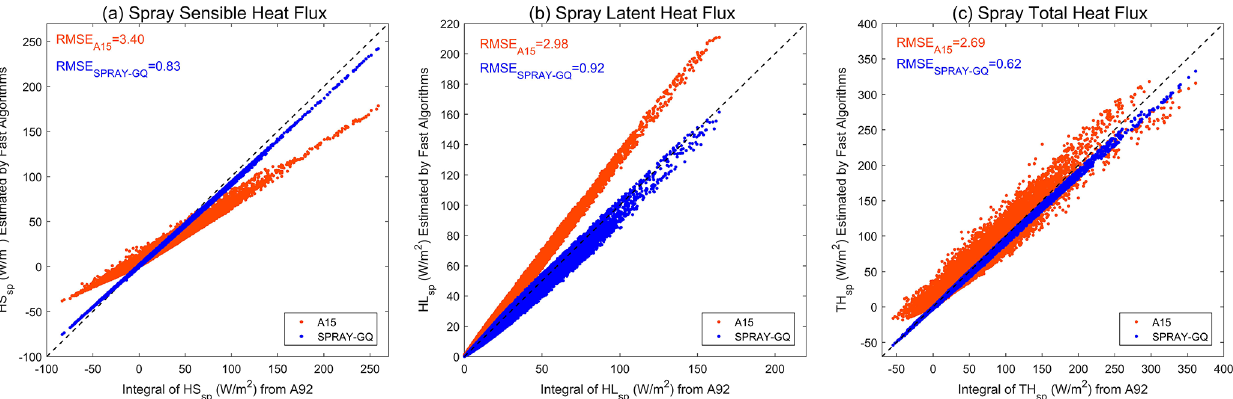
Figure 3. Scatterplots of H S , SP (a) , H L , SP (b) and total heat flux TH SP = H S , SP + H L , SP (c) estimated by fast algorithms ( y axis) vs. those estimated by spectral integral in microphysical parameterization ( x axis). The dotted black line is y = x . The corresponding RMSEs are marked in the upper left